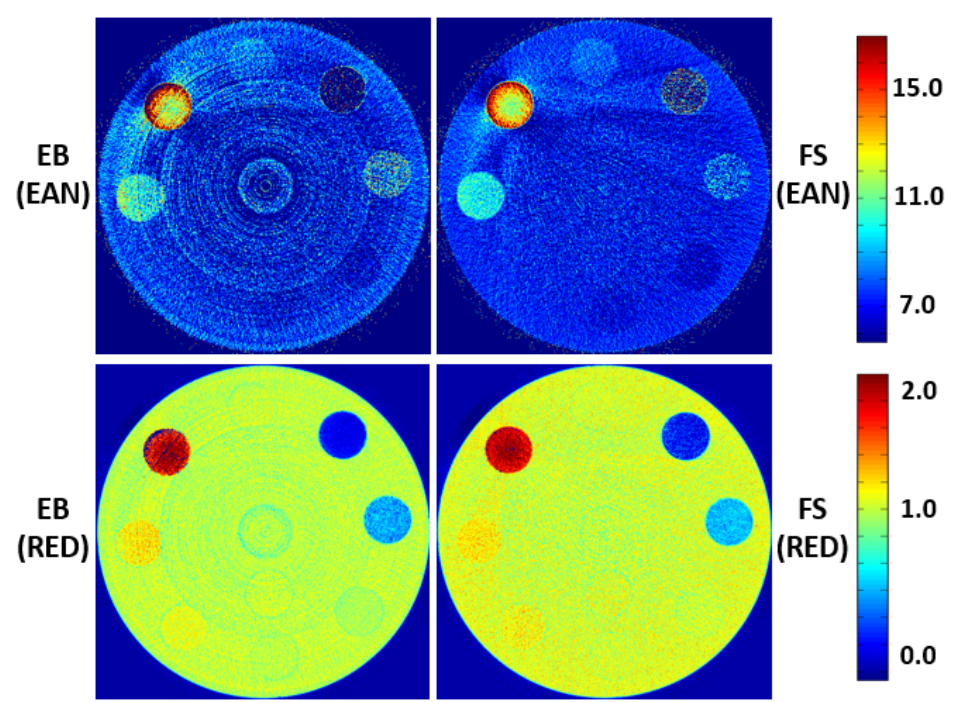
Figure 5. The upper row indicates effective atomic number (EAN) and relative electron density (RED) images acquired in energy bin (EB) mode. Bottom row is EAN and RED images acquired in full spectrum (FS) mode.